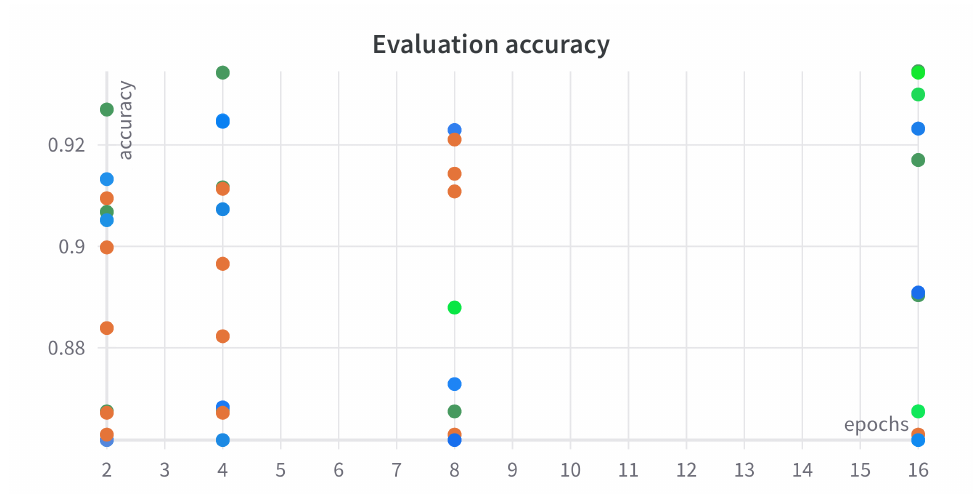
Figure 4. Our different models’ prediction accuracies. The green, blue, and orange circles represent BioBERTa, BioBERT, and BERT models respectively